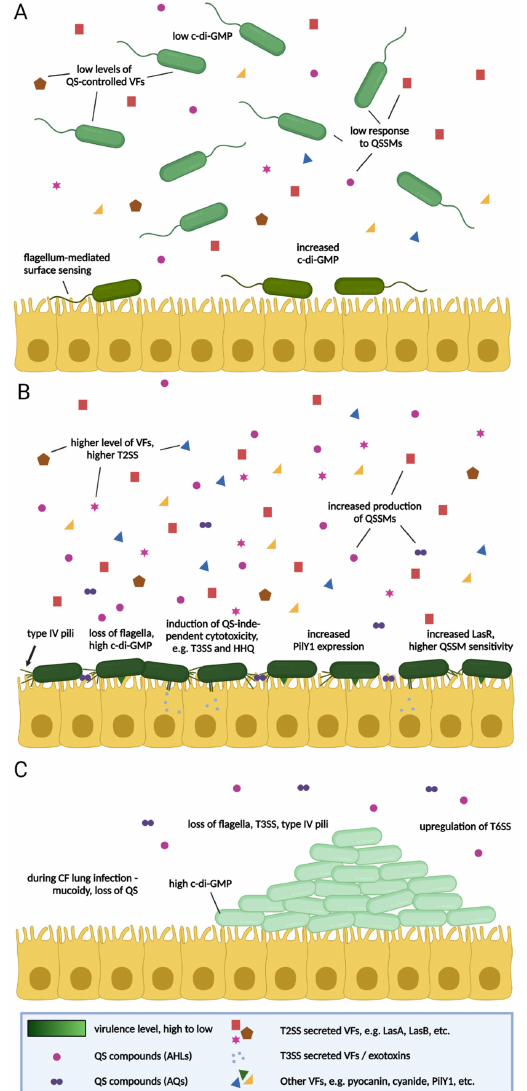
Figure 1. ( A ) Planktonic, free-swimming cells are flagellated, have low c-di-GMP, and, as a result of low sensitivity to QSSMs, exhibit low virulence even when a quorum is reached. Upon encountering a host cell surface, flagellum-mediated surface sensing leads to a rapid increase in c-di-GMP, although virulence remains low in reversibly attached cells. ( B ) Once cells commit to a surface and become irreversibly attached, virulence is further induced via type IV pili-mediated cAMP production. Vfr binds cAMP, activating the transcription of Vfr-regulated virulence genes, including those of the T2SS and T3SS. Virulence factors secreted by the T2SS include the elastases LasA and LasB, the protease, alkaline protease A, exotoxin A, and pyocyanin, while the T3SS secretes various cytotoxins directly into host cells. Vfr also regulates the LasR QS system, as well as the adhesin, PilY1, such that both LasR and PilY1 are up-regulated upon surface attachment. Surface-attached cells demonstrate increased sensitivity to the las QSSMs, causing LasR targets to be more strongly induced. LasR and PilY1 are also important for mediating surface-induced cytotoxicity via their effect on the pqsABCD operon and production of the AQs, including HHQ. PilY1, as well as the Wsp surface-sensing pathway, lead to signalling cascades that result in increased c-di-GMP. ( C ) Eventually, once c-di-GMP is sufficiently high, surface-committed cells start to form microcolonies and biofilms. At this stage, the bacteria lose their motility, down-regulate, or lose many of their host-directed virulence mechanisms, such as the T3SS and the lasR QS system, and upregulate the T6SS, important for inter-bacterial competition. Figure created on